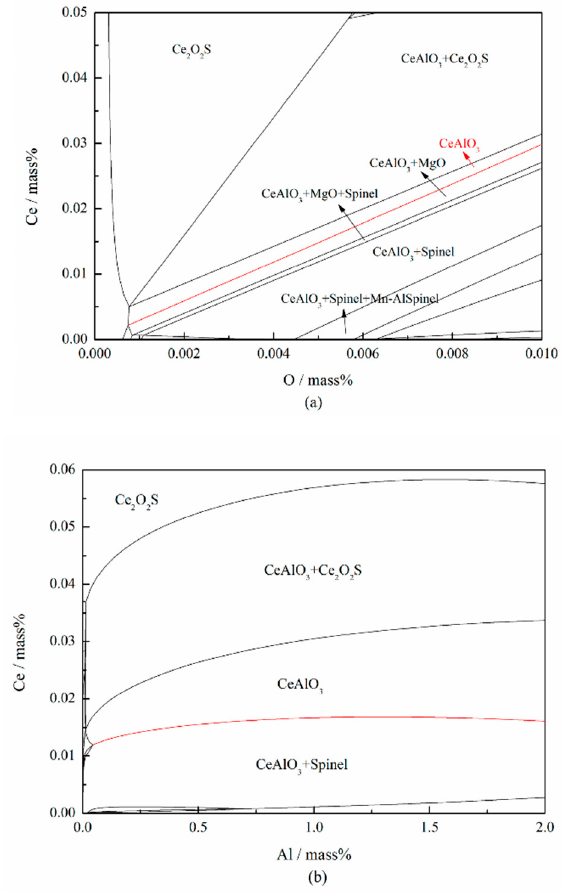
Figure 8. E ff ect of oxygen and aluminum content on inclusions in steel, ( a ) w S = 0.015% and w Al = 0.02%, ( b ) w O = 0.0045% and w S =